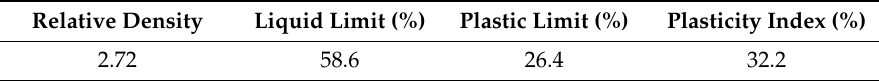
Table 3. Physical properties of Hefei expansive soils (data after Miao et al. [42]). Relative Density